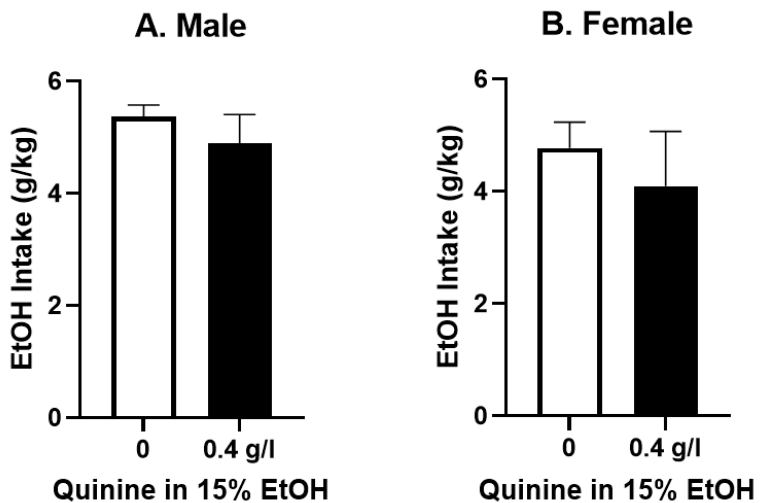
Figure 3. Quinine resistance after 1 week EtOH drinking: Male and female P-rats had one week 24 h continuous access to 15% EtOH. Average EtOH intake for that week is depicted in the open bar (zero quinine condition). The following day, 0.4 g/L quinine was added to EtOH (black bars), with no significant effect of 0.4 g/L quinine on EtOH intake in either male ( A ) or female ( B ) P-rats ( n = 11, 12/group, p > 0.05, paired t -tests).